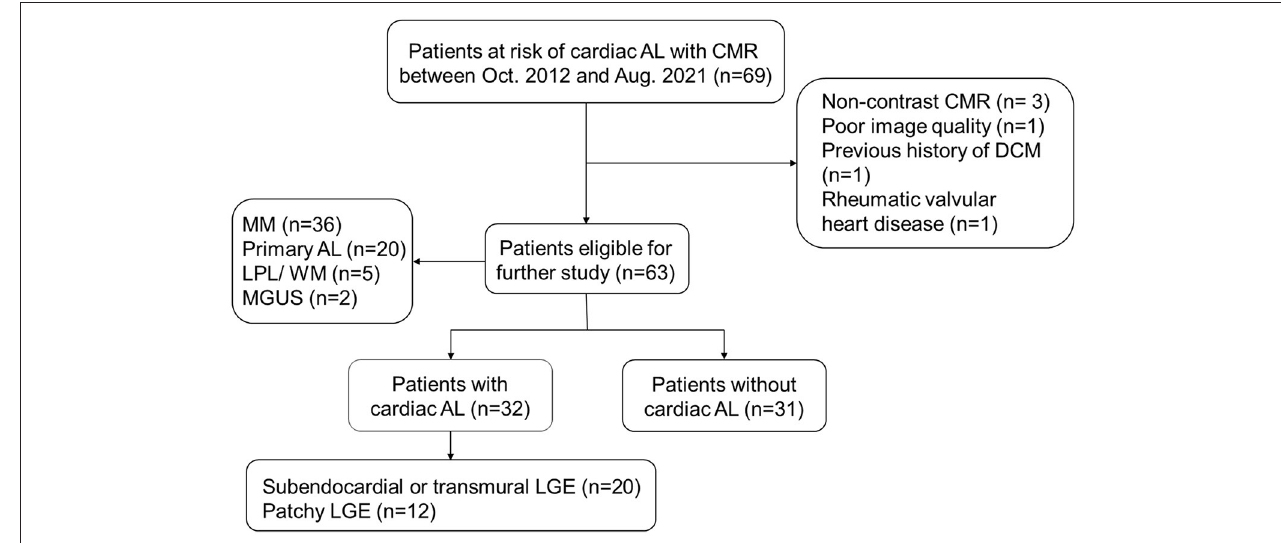
FIGURE 1 | The flowchart of patient